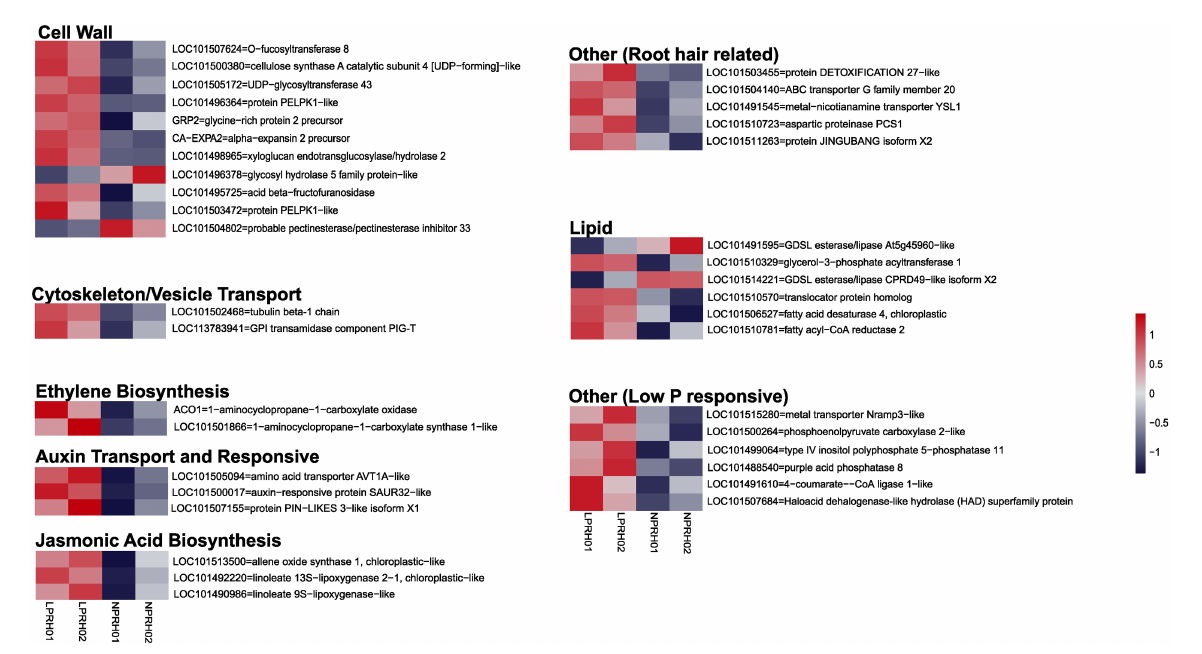
FIGURE 3 Categorization of differentially expressed genes (DEGs) between normal (NP) and low (LP) phosphorus conditions in root hairs (RH). Heatmaps depict differentially expression of genes using row scaled log 2 counts per million (CPM) values, and DEGs are denoted using the gene id and description. DEGs are categorized according to their function and role in RH development or LP response. Each category can contain both up- and downregulated